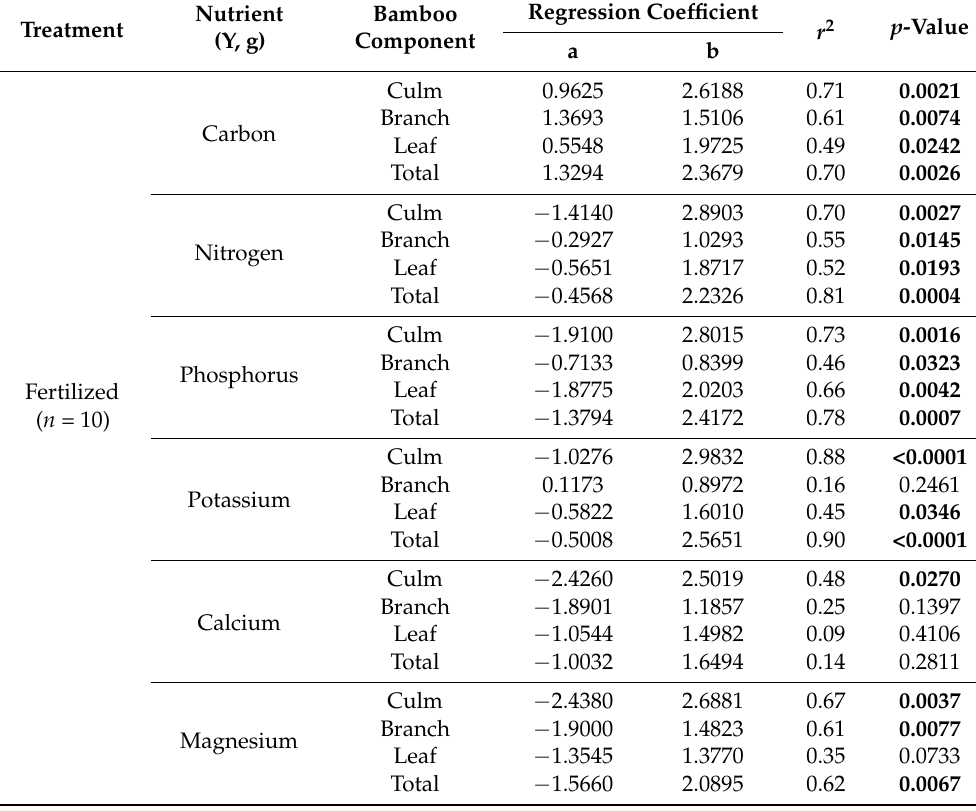
Table A1. Allometric equations (log 10 Y = a + b × log 10 DBH) to estimate nutrient content of a Moso bamboo. DBH (cm). Bold values denote significance at p <